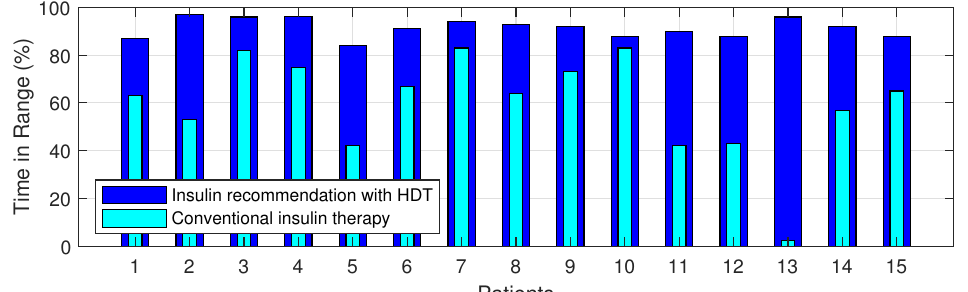
Figure 27. Percent improvement in Time in Range for 15